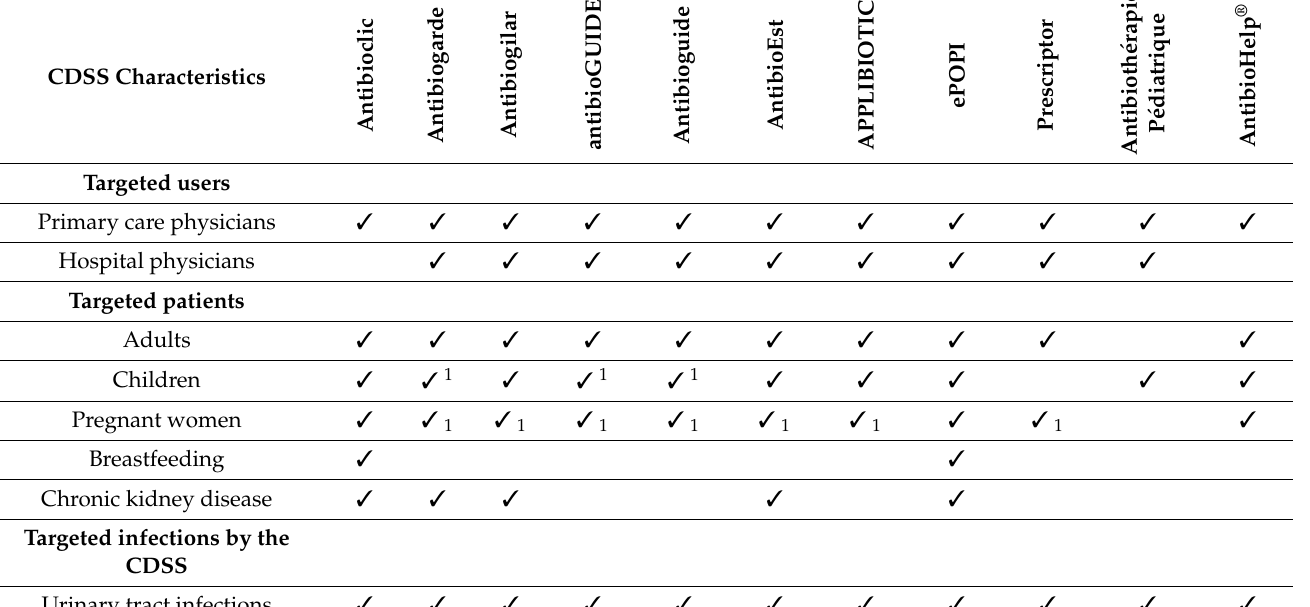
Table 2. Individual characteristics of the CDSSs regarding targeted users, patients, and infections.